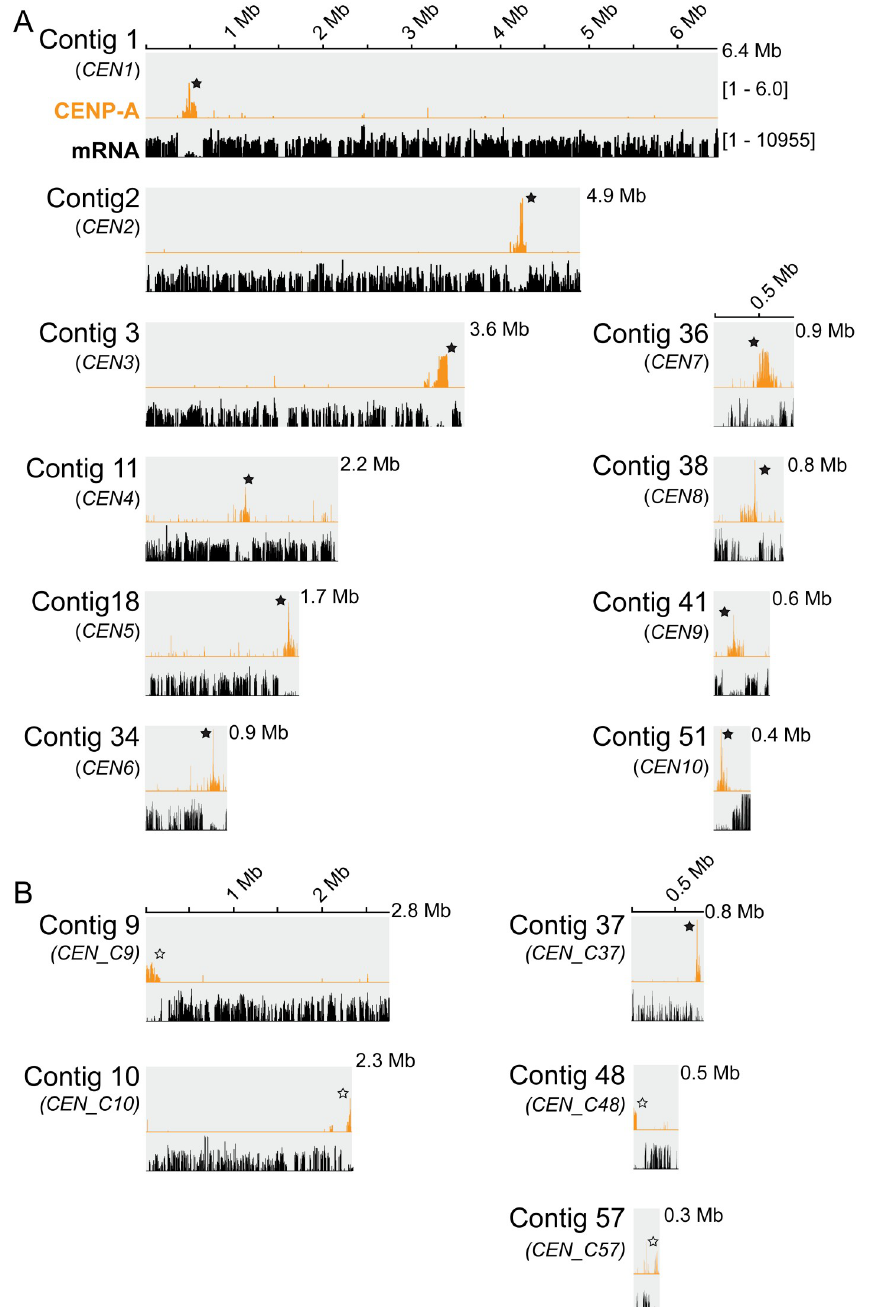
Fig 2. Contigs in the Psojae2019.1 assembly demonstrating CENP-A enrichment based on ChIP-seq. (A) 10 contigs that harbor fully assembled CENP-A binding sites. (B) Five contigs that possess incompletely assembled CENP-A binding regions. All contigs are drawn to scale and the ruler indicates the length of the contigs. All CENP-A profiles shown were normalized to input DNA. mRNA profiles are shown as log-scales. Solid stars indicate the CENP-A enriched regions within contigs; hollow stars denote broken centromeres at the